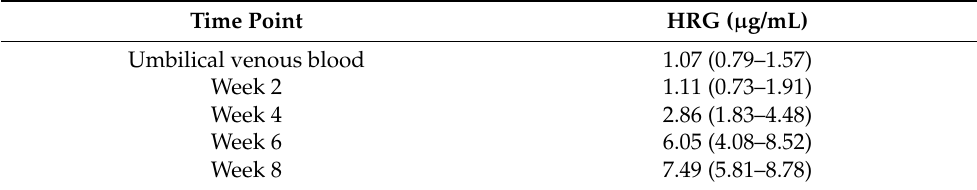
Table 4. Longitudinal Change in